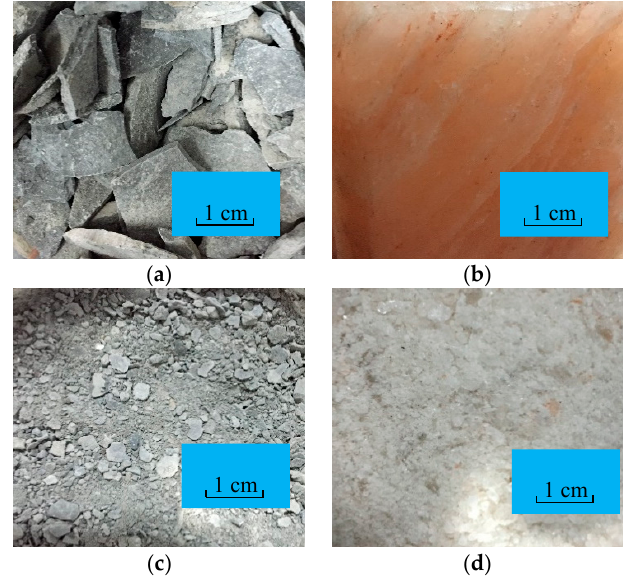
Figure 3. Material selection. ( a ) Mudstone; ( b ) rock salt; ( c ) the particles of mudstone; ( d ) the particles of rock salt.